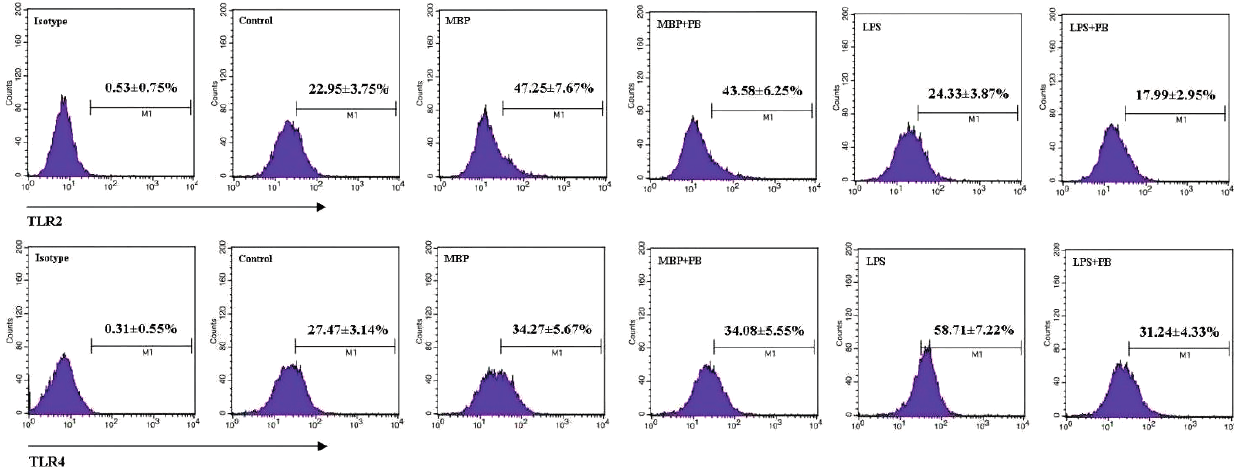
Figure 4. Effects of MBP on expression of TLR2 and TLR4 in RAW264.7 macrophages. RAW264.7 cells were treated with 5 μ g/mL of MBP or 1 μ g/mL of LPS for 48 h in the presence or absence of 5 μ g/mL of polymyxin B (PB). Expression of TLR2 and TLR4